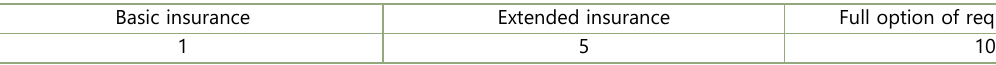
Table 6. Point scale for the insurance level evaluation (source: own contribution)